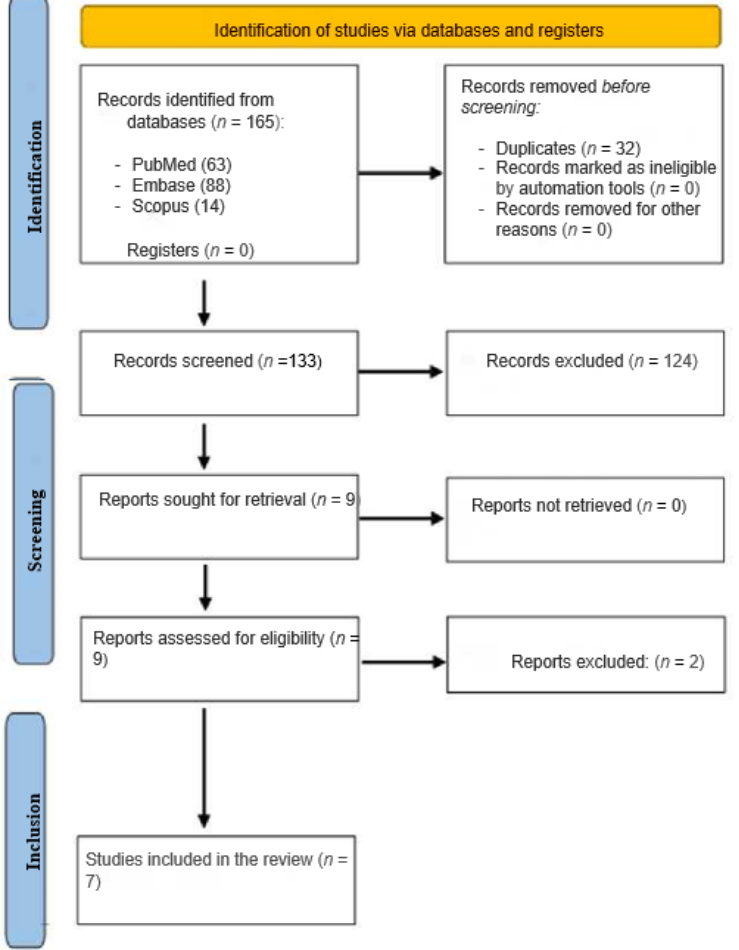
Figure 1. Scoping review workflow.